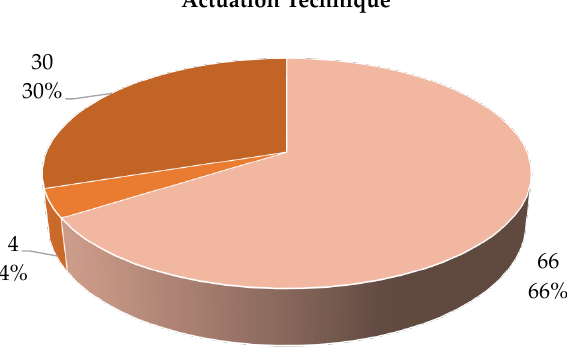
Figure 27. Distribution of the actuation technique used in the soft gloves of the revised